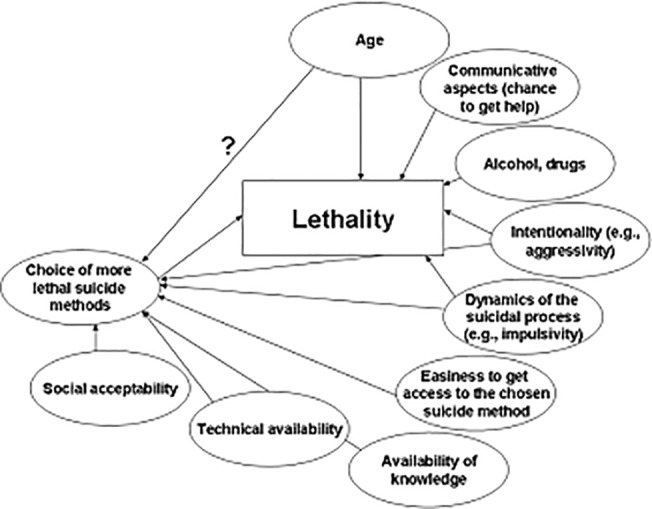
Potential impact factors on gender differences in lethality of suicidal acts.